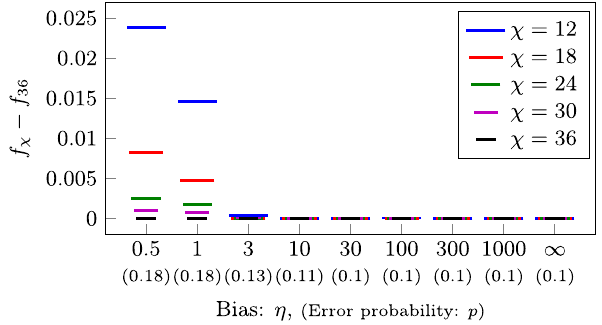
FIG. 20. (a) Distance five triangular 6.6.6 color code with logical operators given by a product of Z along the bottom edge and a product of X along the left edge. (b) Color-code stabilizers. (c) Tensor network corresponding to the coset probability of a distance five color code; gray disks represent qubit tensors; white stars represent stabilizer tensors; and lines represent bonds. (d) Equivalent tensor network as a square lattice.